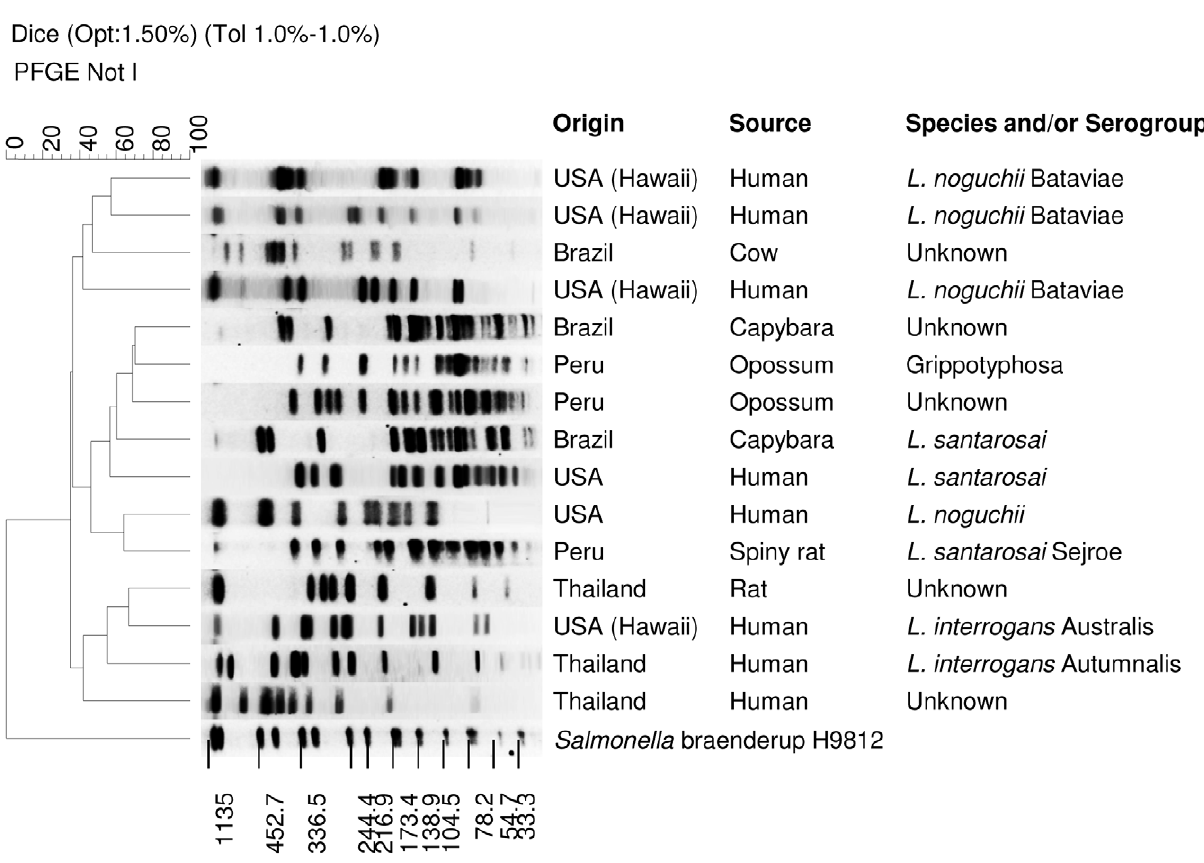
Figure 3. PFGE patterns of unidentified, potentially new serovars. Salmonella Braenderup H9812 is shown as the size standard.